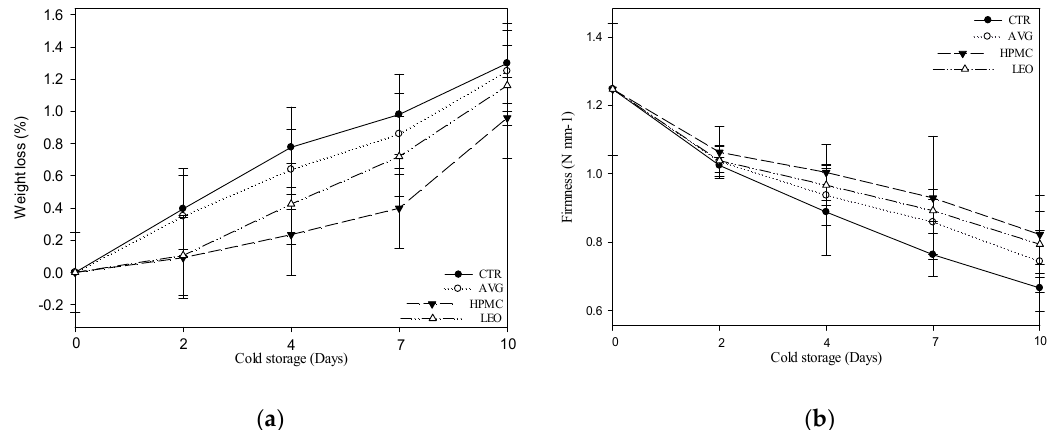
Figure 3. ( a , b )Weight loss (%) and firmness (N·mm −1 ) of kiwifruit slices coated with AVG, HPMC and LEO treatments and not treated (CTR) at day 0 and after 2, 4, 7 and 10 days of cold storage at 4 ± 1 °C and 90% ± 5% relative humidity (RH) in dark conditions. Values indicate the means, and the bars indicate the standard deviations of the replicates ( n = 3). Abbreviations: CTR, uncoated fruit slices, AVG, fruit slices coated with 40% v/w of Aloe vera gel only, HPMC, fruit slices coated with 40% v/w of Aloe vera gel + 0.1% v/w of hydroxypropyl methylcellulose and LEO, fruit slices coated with 40% v/w of Aloe vera gel + 0.1% v/w of lemon essential oil.